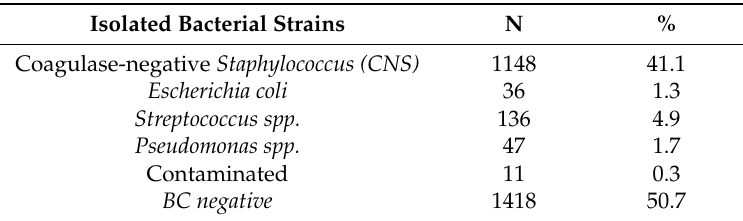
Table 4. Distribution of pathogenic microorganisms found in infected mammary glands.